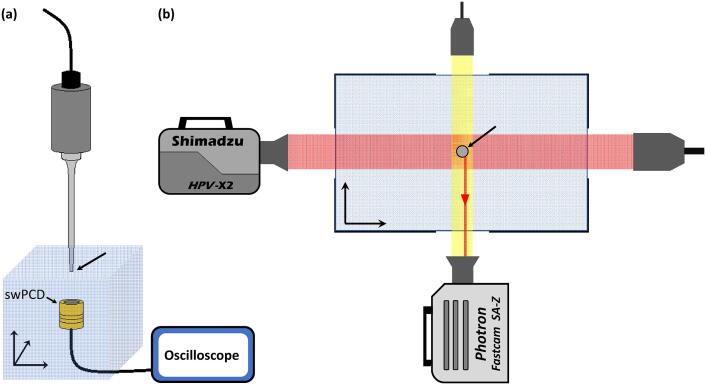
Schematic representations of the experimental arrangement (a) the ultrasonic horn and swPCD. (b) top-down view of the dual-perspective high-speed imaging configuration. The horn-tip is arrowed in both representations.